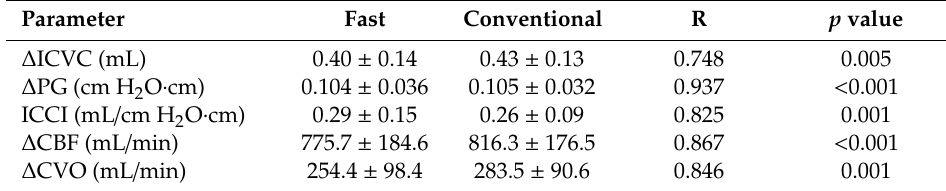
Table 1. Comparison of proposed fast and conventional PC-cine MRI methods in terms of peak-to-peak intracranial volume change ( ∆ ICVC), peak-to-peak pressure gradient ( ∆ PG), intracranial compliance